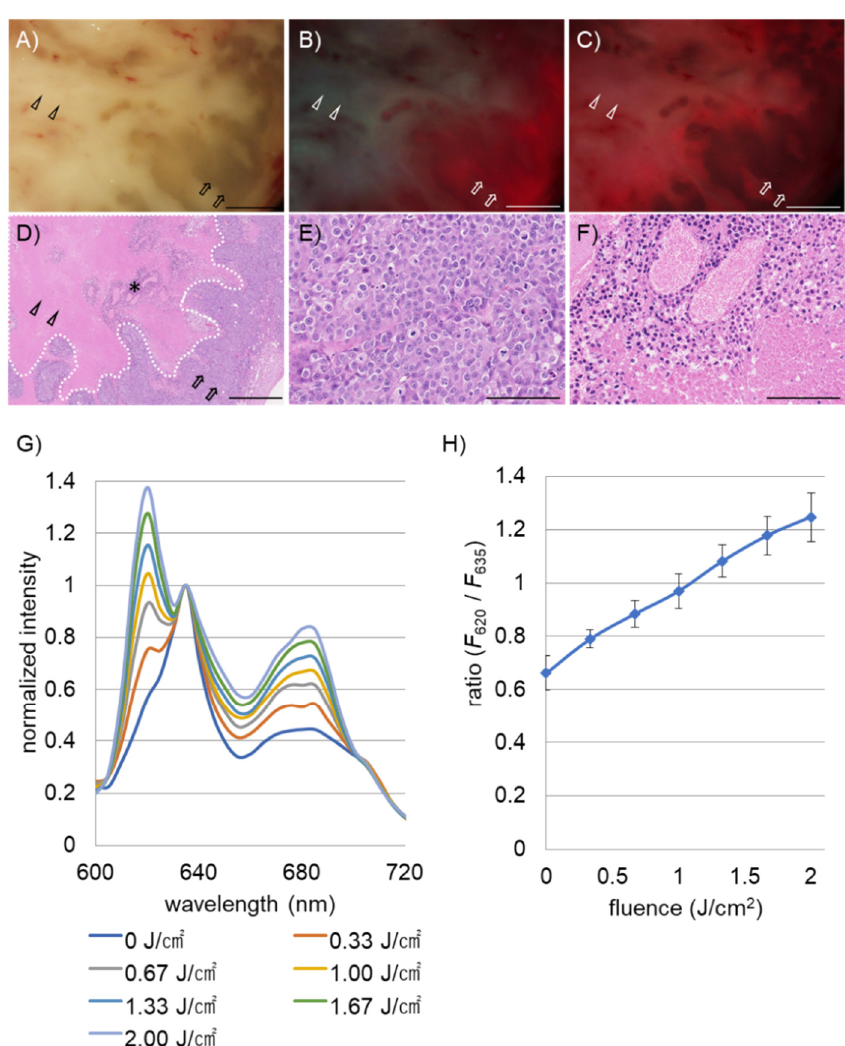
Figure 2. Fluorescence analyses of necrotic and viable tumor tissues resected from B88 squamous cell carcinoma xenografts. Analysis was performed 6 h after the administration of 5-ALA. Representative white-light ( A ), fluorescent ( B , C ) (excitation, 405 nm; emission, >430 nm), and HE-stained ( D – F ) images of a subcutaneous xenograft. The fluorescence images shown in B and C were acquired before and after irradiation of 405 nm wavelength light (2.00 J/cm 2 ), respectively. Arrowheads and arrows denote necrotic and viable tumor lesions, respectively. Note that red fluorescence signal was increased in the necrotic lesion after irradiation (arrowheads in B , C ). Dotted area in D circles necrotic core of the tumor. Degenerated tumor cells around blood vessels were observed in the necrotic core (asterisk in D). Magnified histological images of viable tumor cells, and the degenerated tumor cells in the necrotic core, are shown in E and F, respectively. Scale bar, 1 mm ( A – D ) and 100 µm ( E – G ). Typical fluorescence spectral change of necrotic lesions after exposures with different fluence of irradiation light. ( H ) Ratio between fluorescence intensities at 620 nm and 635 nm of necrotic lesions as a function of fluence of irradiation light. Each result shown in H represents the mean and standard deviation (error bars) of the experiment performed in triplicate.